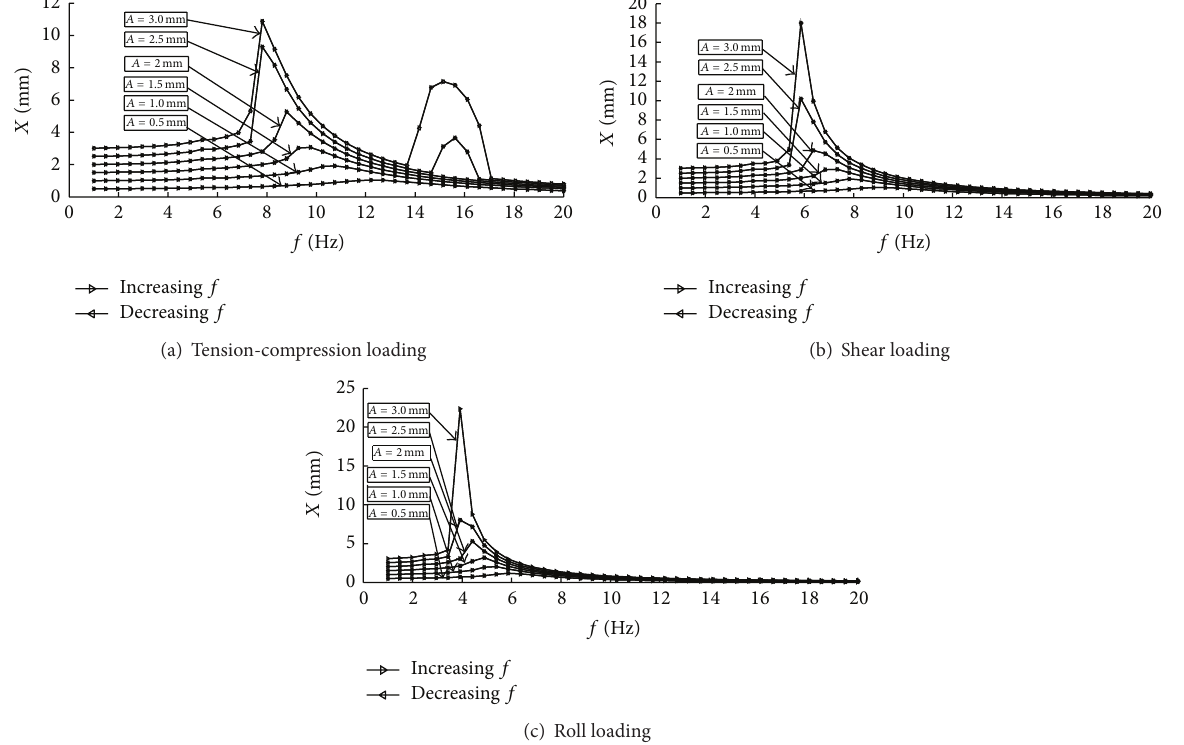
Figure 17: The simulated frequency response curves of relative